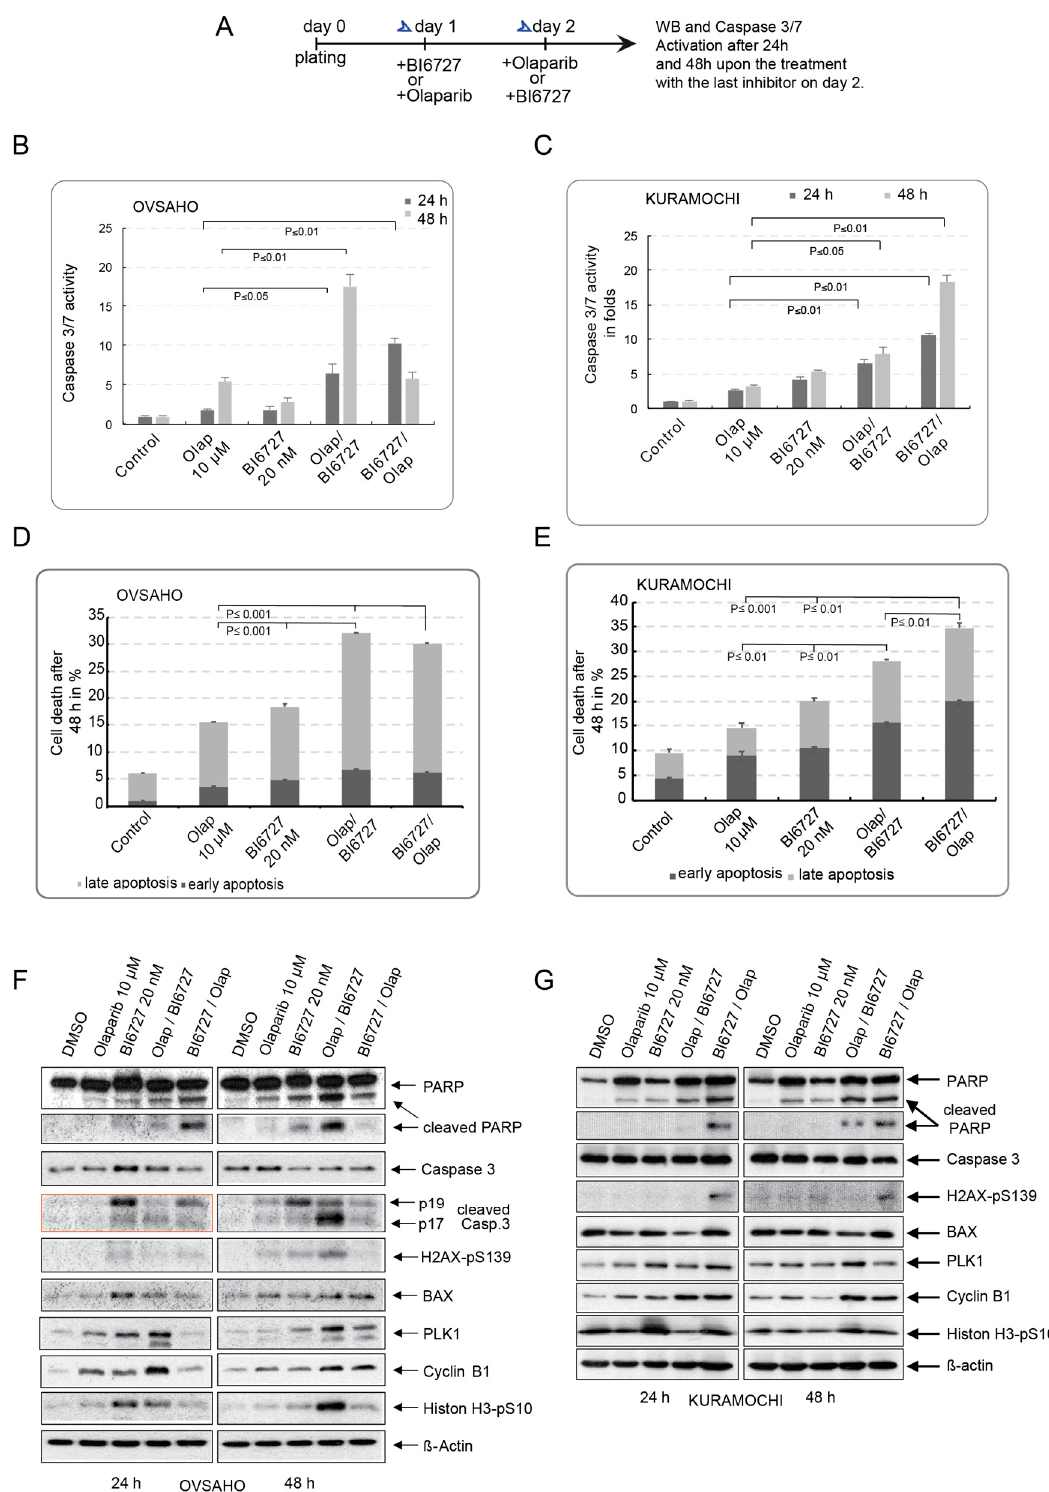
Figure 2. Sequential PARPi and PLKi sensitize BRCA2-deficient HGSOC to Olaparib treatment independent of the KRAS status. ( A ) Treatment schedule: KURAMOCHI and OVSAHO cells were first incubated with a single treatment consisting of Olaparib (10 µM) or BI67272 (20 nM) and the sequential combinations Olaparib/BI6727 or BI6727/Olaparib at days 1 and 2. The cells were har- vested 24 h and 48 h post-treatments, and further experiments were carried out. ( B , C ) Apoptosis was assessed by measuring Caspase 3/7 activity in cell lysates of cells incubated with the different single or combinatorial treatments. The results are presented as mean ± SD. ( n = 3, p ≤ 0.001, p ≤ 0.01,